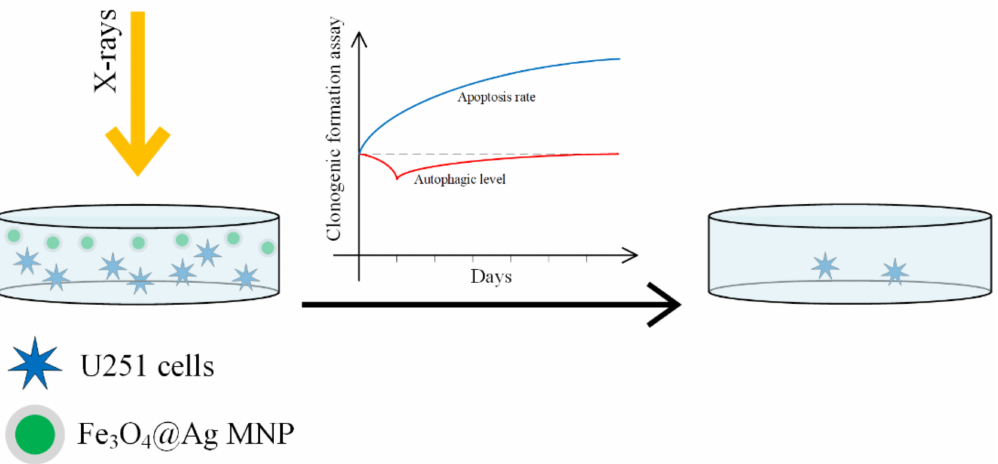
Figure 14. Fe 3 O 4 @Ag nanoparticles acting as a nano-radiosensitizer for GBM cellular culture treatment. The MNP radiosensitivity magnification effect is due to a decrease in the autophagy at the beginning of the treatment and followed by an increase in the